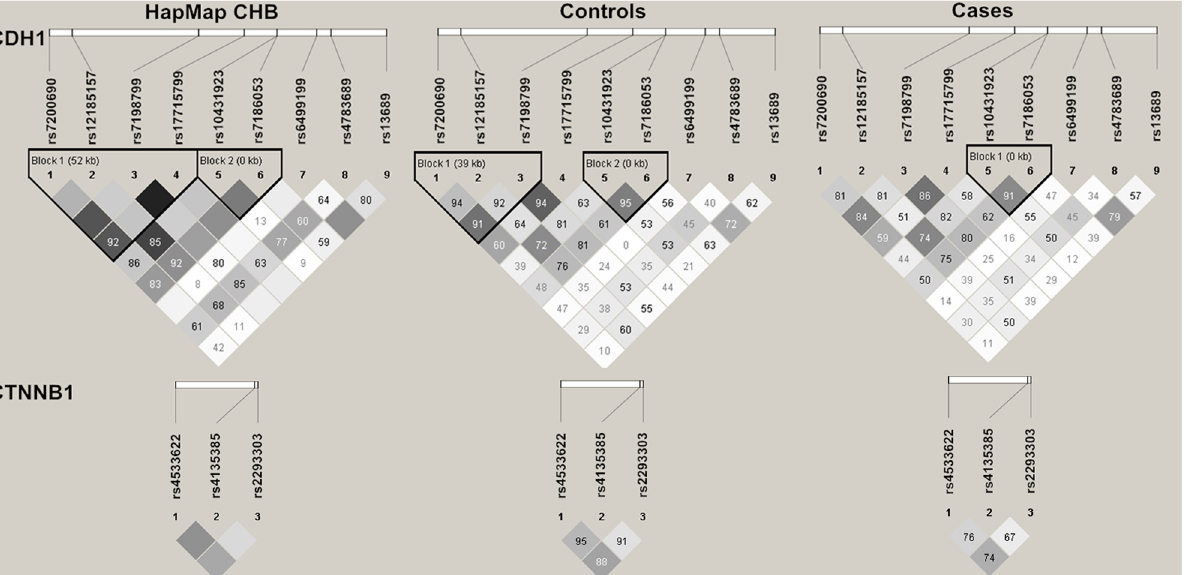
Fig 1. LD maps of htSNPs in HapMap CHB population, controls and breast cancer cases. The values shown in each diamond are the D ’ ×100 (10 means 0.10, 1 means 0.01) and indicate pairwise LD between htSNPs. The dark grey-to-white gradient reflects higher to lower LD values. Dark grey diamonds without a number indicate a complete LD (D ’ =